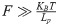
Extension of partially covered polymers as function of the pulling force.(Panel A) Extension of a polymer in the presence of a ligand as a function of the applied force for different coverages c, occluded monomers per ligand m, and a/m ratios, for a ligand with a single binding mode. The dotted vertical line marks the force value KB
T/Lp, which separates the low and the high-force regime. In the high-force limit (F≫KBTLp), the extension x(F) depends only on both a/m and c. Changes in the Kuhn length per occluded monomer a/m shift the curves, but do not alter the slopes. However, changes in coverage c do alter these slopes. (Panel B): In the intermediate-force regime (F∼KBTLp), the three parameters (c, a/m, and m) have subtle effects on the extension of the polymer. In the low-force limit (F≪KBTLp) the extension x(F) is proportional to the force F and the proportionality constant is given in Eq (11). For both panels, d0 = 0.57 nm. K0 = 700 pN, Lp = 0.715 nm (which are of the order of the values for ssDNA [24]), and KBT = 4.11 pN nm, the value at 25°C.